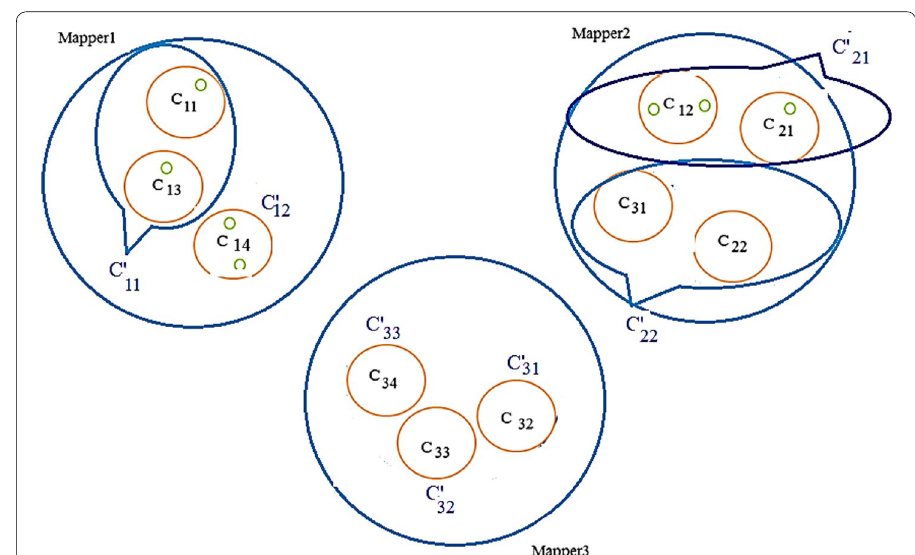
Fig. 4 Merge of clusters to new clusters in mappers (step 3 of phase